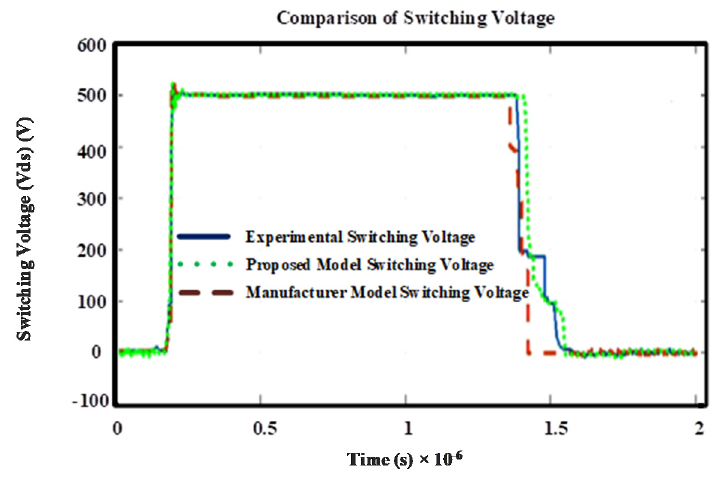
Figure 20. Comparison of switching voltage waveforms of models with DPT results.